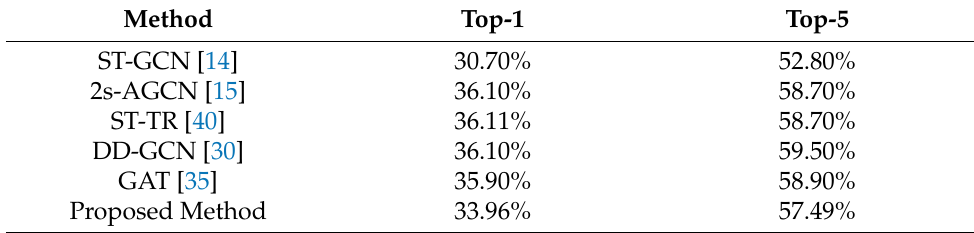
Table 3. Comparisons of validation accuracy with state-of-the-art methods on the Kinetics skele- ton